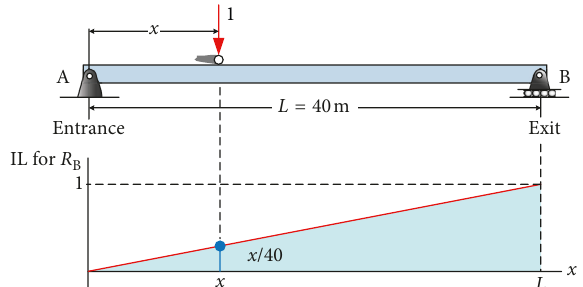
Figure 16: Influence lines for support reaction at the exit side.